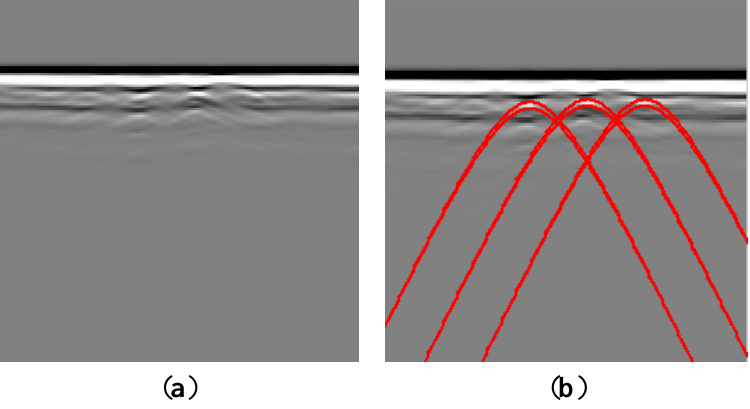
Figure 8. Example of test metal point targets data. ( a ) GPR image; ( b ) Processed result with detected patterns. The detected hyperbola is the red color line; ( c ) The position estimation results of the real point data.